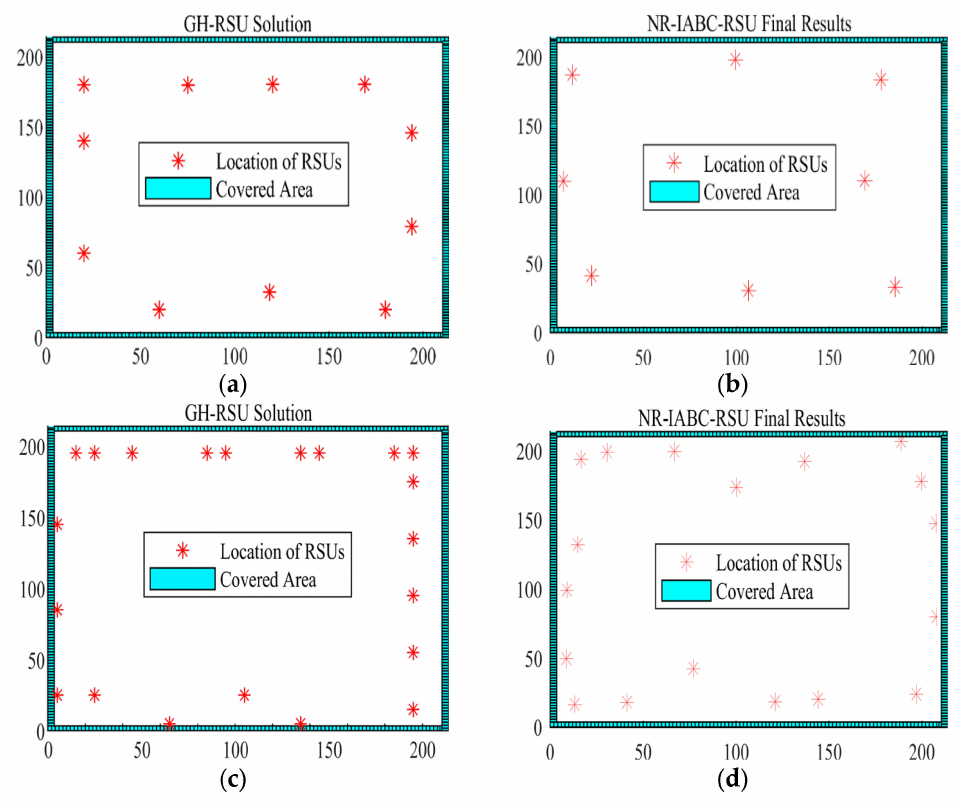
Figure 4. An illustration of system deployment diagram: ( a ) b 0 = 1, GH; ( b ) b 0 = 1, NR-IABC; ( c ) b 0 = 2, GH; ( d ) b 0 = 2,